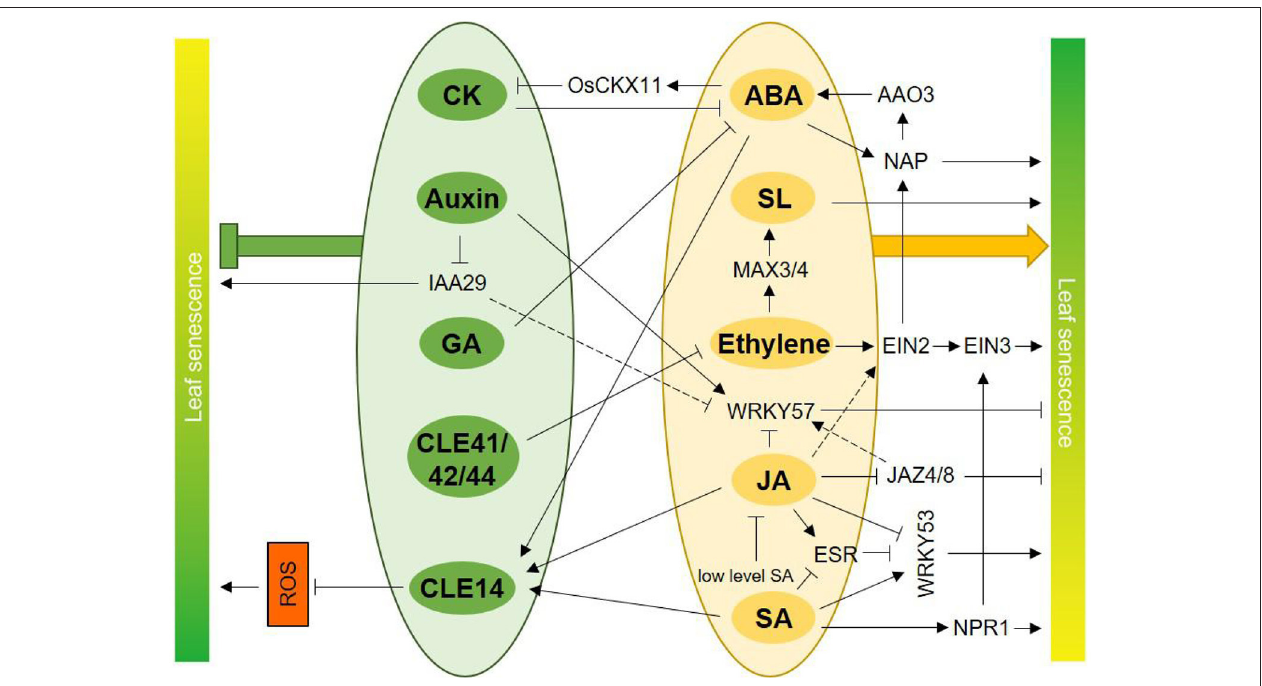
FIGURE 2 | Interplays among classic and peptide hormones in senescence regulation. CK inhibits ABA biogenesis and ABA represses CK content through elevating expression of OsCKX11 . GA treatment inhibits the increase of ABA content during leaf senescence. CLE14 is induced by ABA, JA, and SA, and CLE14 act as a “brake signal” to these hormones-induced leaf senescence though repressing ROS level. CLE41/42/44 delay leaf senescence by antagonizing with ethylene signaling pathway. Ethylene promotes SL biosynthesis via inducing expression of MAX3 and MAX4 during senescence, so ethylene and SL coordinately regulate leaf senescence. Phytohormone ABA and the core component of ethylene, EIN2, induce the expression of NAP, a positive regulator of leaf senescence. Conversely, NAP increases ABA biosynthesis through inducing expression of AAO3 . JA-induced leaf senescence is dependent on EIN2. WRKY57 is a negative regulator of JA-induced leaf senescence. JA inhibits accumulation of WRKY57 protein and auxin promotes WRKY57, so that WRKY57 acts as an integrator of JA and auxin. Besides, the repressors of JA and auxin signaling pathway, JAZ4/8 and IAA29 both interact with WRKY57, which may be another regulatory level of interplay between JA and auxin. Ethylene and SA synergistically accelerate leaf senescence through interaction of NPR1 and EIN3 and a concomitant promotion of SAGs expression. SA represses the JA-inducible protein ESR, and ESR inhibits the functions of WRKY53, a positive regulator of leaf senescence. Furthermore, JA reduces the expression of WRKY53 and SA induces WRKY53 oppositely. Thus, ESR and WRKY53 are integrators of antagonism between JA and SA in leaf senescence. Moreover, low concentration of SA can alleviate JA-induced leaf senescence. Generally, hormones presented in green ellipses including CK, auxin, GA, CLE41/42/44, and CLE14 delay leaf senescence (bold green symbol). Hormones in orange ellipses including ABA, SL, ethylene, JA, and SA promote leaf senescence (bold orange